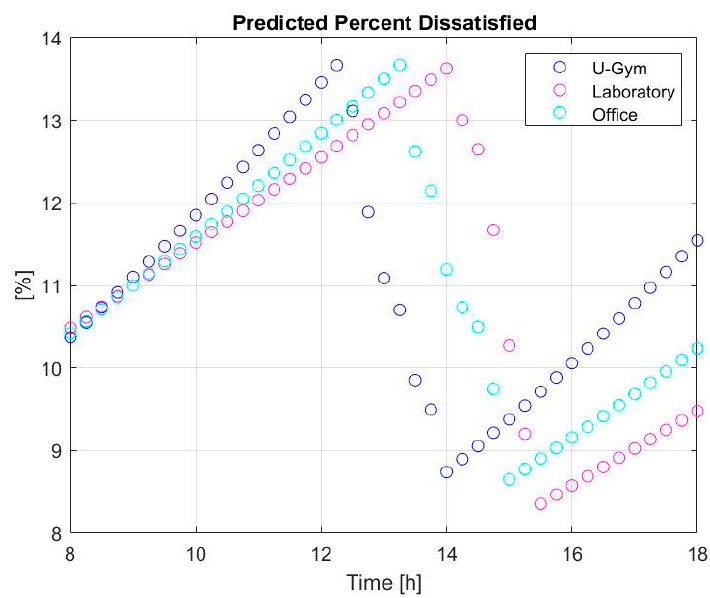
Figure 19. Predicted percent dissatisfied values.